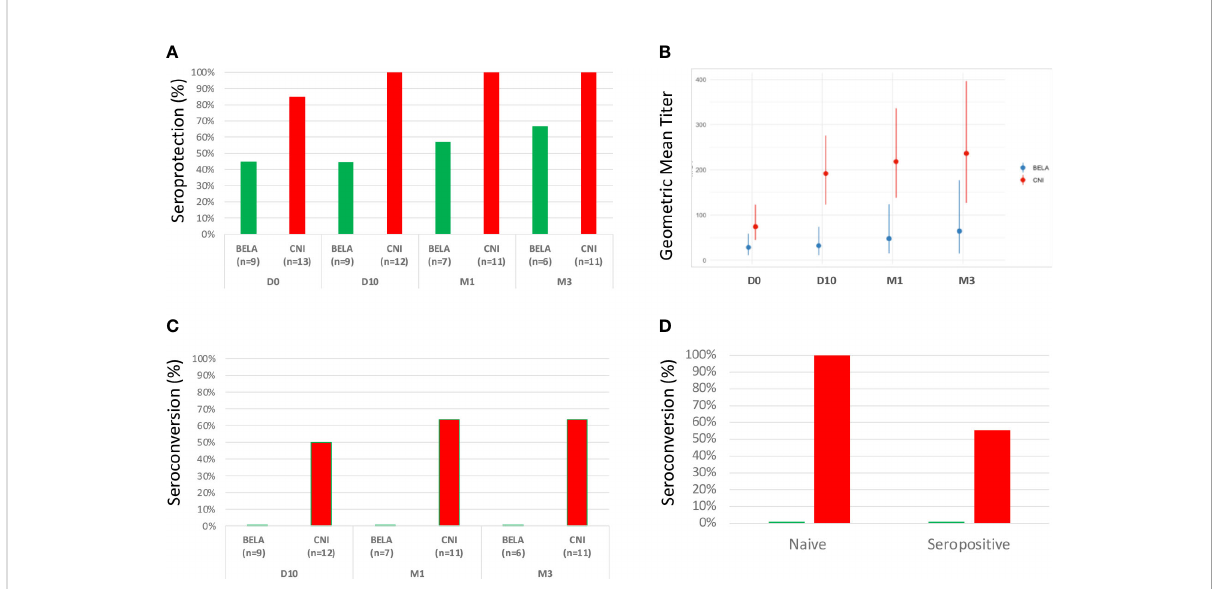
FIGURE 4 Serological responses after In fl uenza vaccination. Figure 4A. Seroprotection rate at baseline and evolution after vaccination. Figure 4B. Kinetics of H1N1 antibody titers (GMTs) before and after vaccination. Figure 4C. Seroconversion rate after vaccination. Figure 4D. Comparison of seroconversion rates at M3 between naïve and seropositive patients prior to vaccination according to each type of